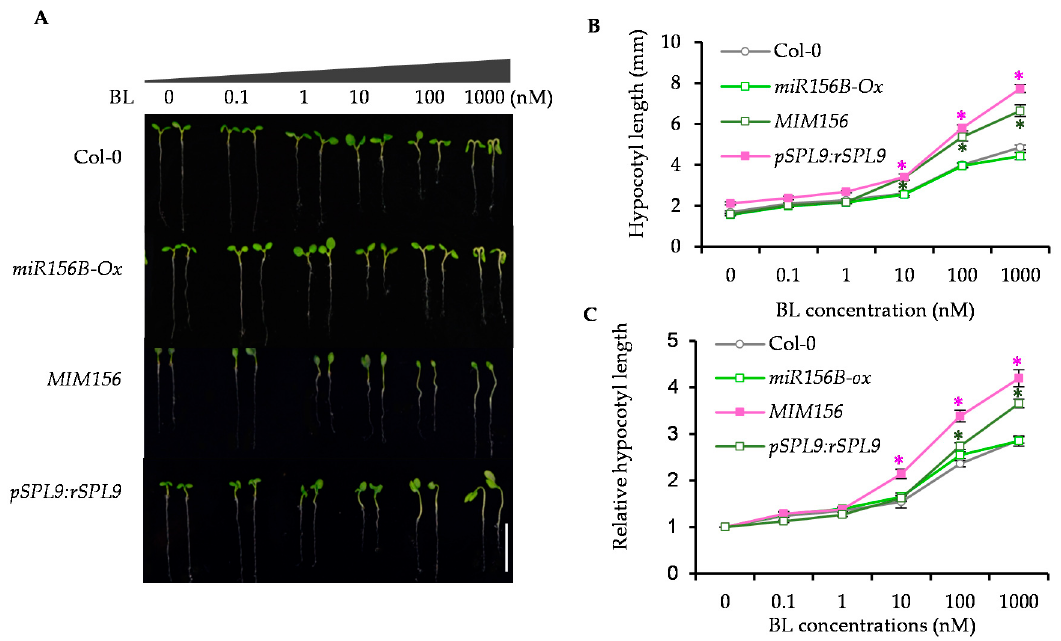
Figure 2. The MIM156 and pSPL9:SPL9 transgenic plants displayed the increased BR sensitivity on hypocotyl elongation. ( A ) Representative images of seven-day-old seedlings of wild-type and miR156B-Ox , MIM156 and pSPL9:rSPL9 grown on the ½ MS medium with different concentrations of brassinolide (BL). ( B , C ) Activated SPL9 by expressing the mimic miR156 or the miR156-resistant form of SPL9 increased the BR response. The hypocotyl lengths were measured from at least 30 plants. Relative hypocotyl length were average of 30 plants and normalized to the untreated plants. Error bars represent standard deviation. * p < 0.05.